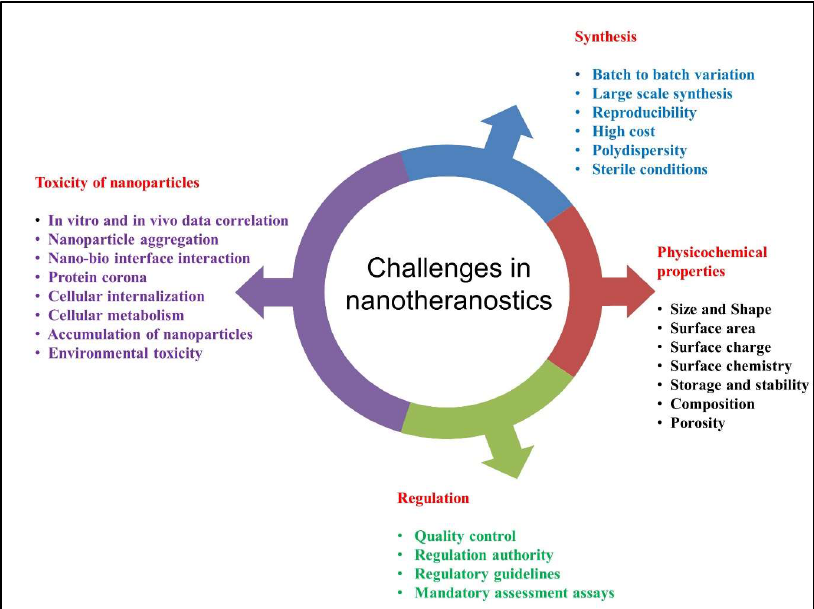
Figure 7. Challenges associated with nanotheranostics for reaching from lab to clinic; the spectra of challenges include synthesis, controlled physico-chemical properties, safety, and regulations.